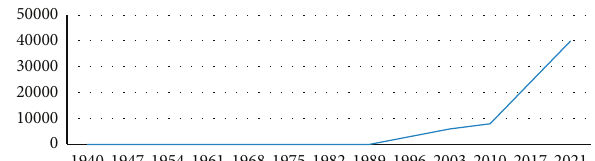
Figure 26: Article distribution by years for meta-analysis articles.